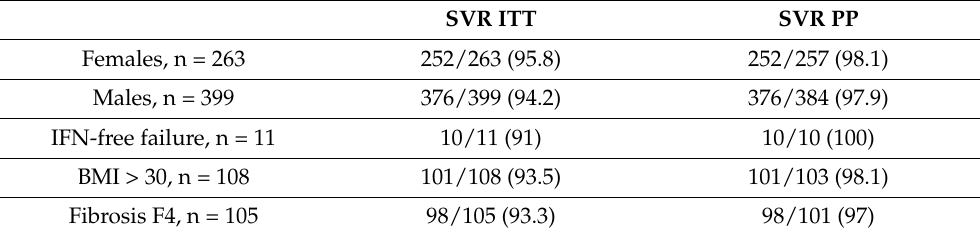
Table 6. Treatment effectiveness in